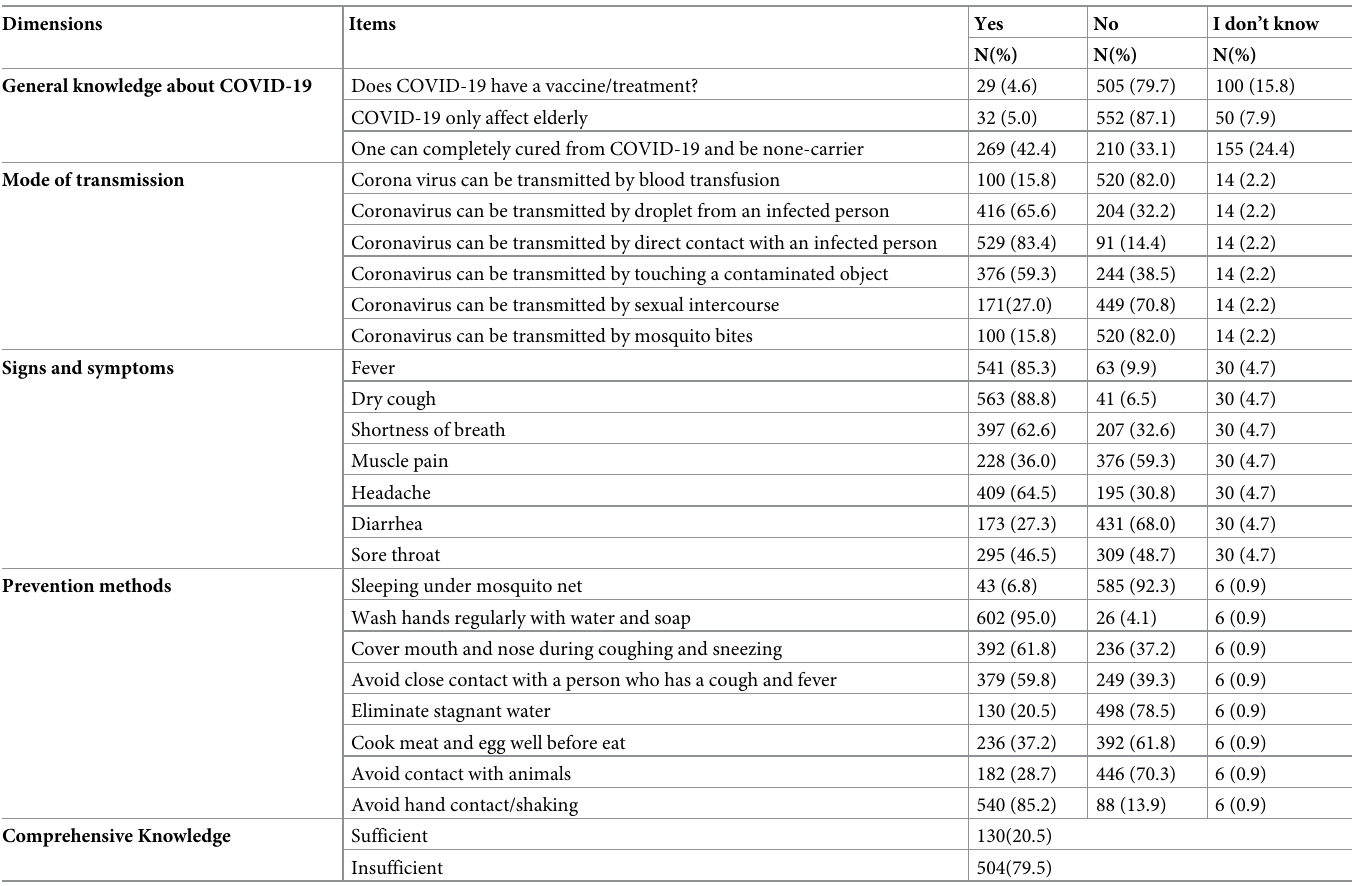
Table 4. Knowledge about COVID-19 in Qellam Wallaga Zone, Oromia, Ethiopia, 2020.